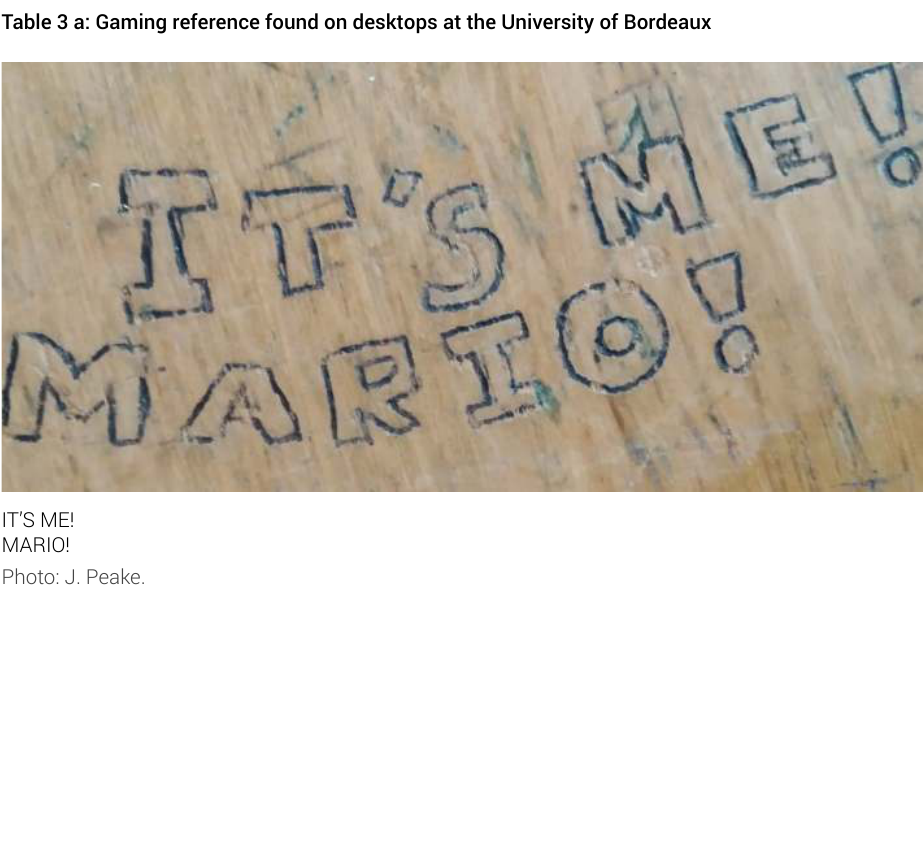
Table 3 a: Gaming reference found on desktops at the University of Bordeaux